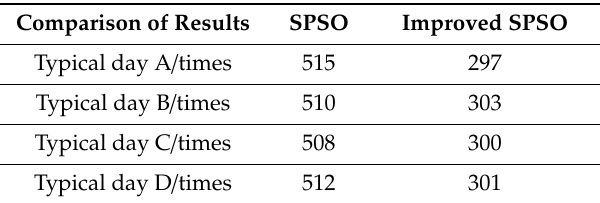
Figure 15. The comparison of the joint output curves between the two strategies on typical day D. Table 2. Comparison of two algorithm covergence